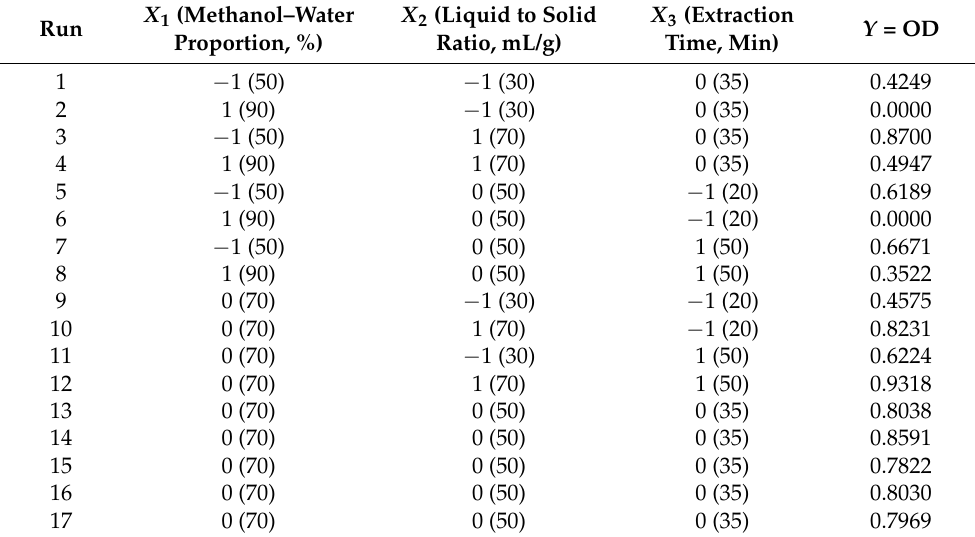
Table 2. The Box-Behnken design matrix and the results for response yield (OD value) of Clinopodium polycephalum .